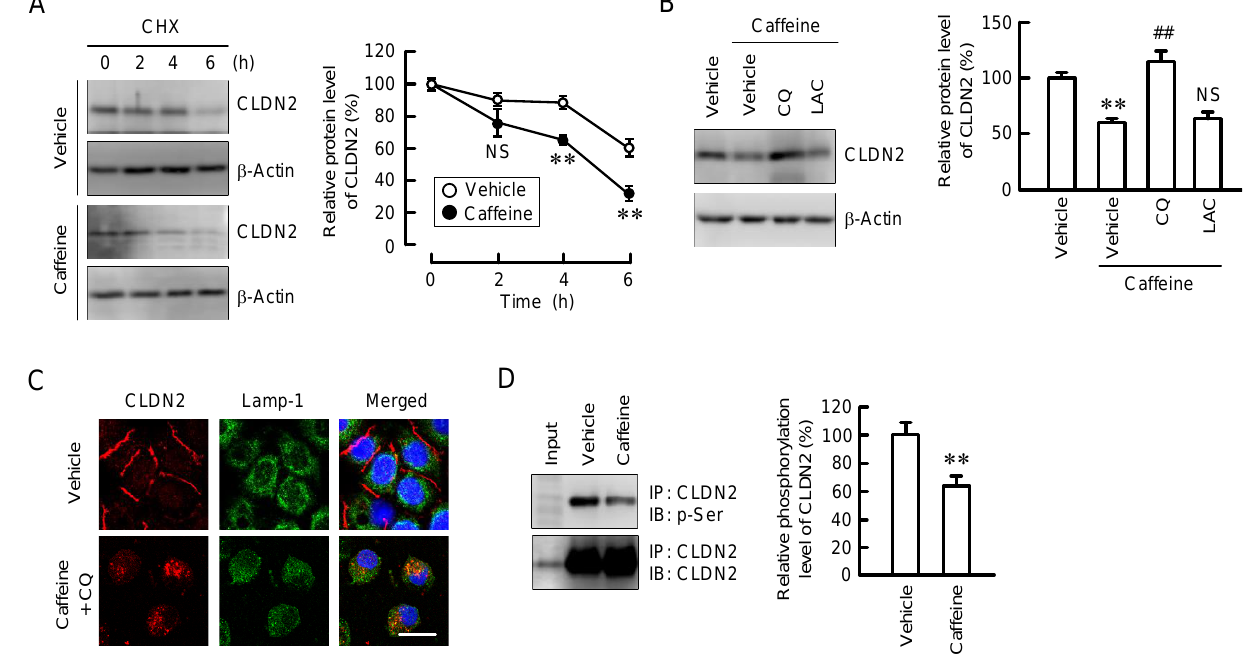
Figure 5. Effect of caffeine on protein stability of CLDN2. ( A ) Cells were incubated without (vehicle) or with 200 μM caffeine for the indicated periods in the presence of 3 μg /mL CHX. The protein level of CLDN2 is represented as a percentage relative to 0 h. ( B ) Cells were incubated in the absence (vehicle) and pres ence of 200 μM caffeine, 10 μM chloroquine (CQ), or 10 μM lactacystin (LAC) for 24 h. The protein level of CLDN2 is represented as a percentage relative to vehicle. ( C ) Cells were incubated in the absence or presence of 200 μM caffeine for 2 h. After immun oprecipitation with anti-CLDN2 antibody, aliquots were blotted with anti-phosphoserine and anti-CLDN2 antibodies. ( D ) The phosphoserine level of CLDN2 is represented as a percentage relative to vehicle. Input is loaded in the left lane. n = 5 – 7. ** p < 0.01 compared with 0 h or vehicle. ## p < 0.01 compared with caffeine alone. NS p > 0.05 compared with 0 h or caffeine alone.